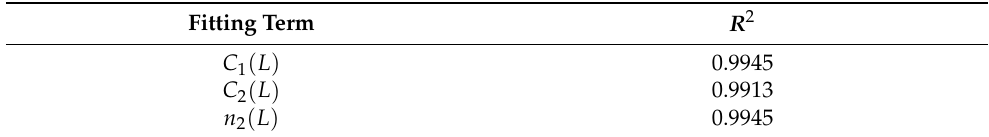
Table 4. Correlation coefficient values of fitting terms.